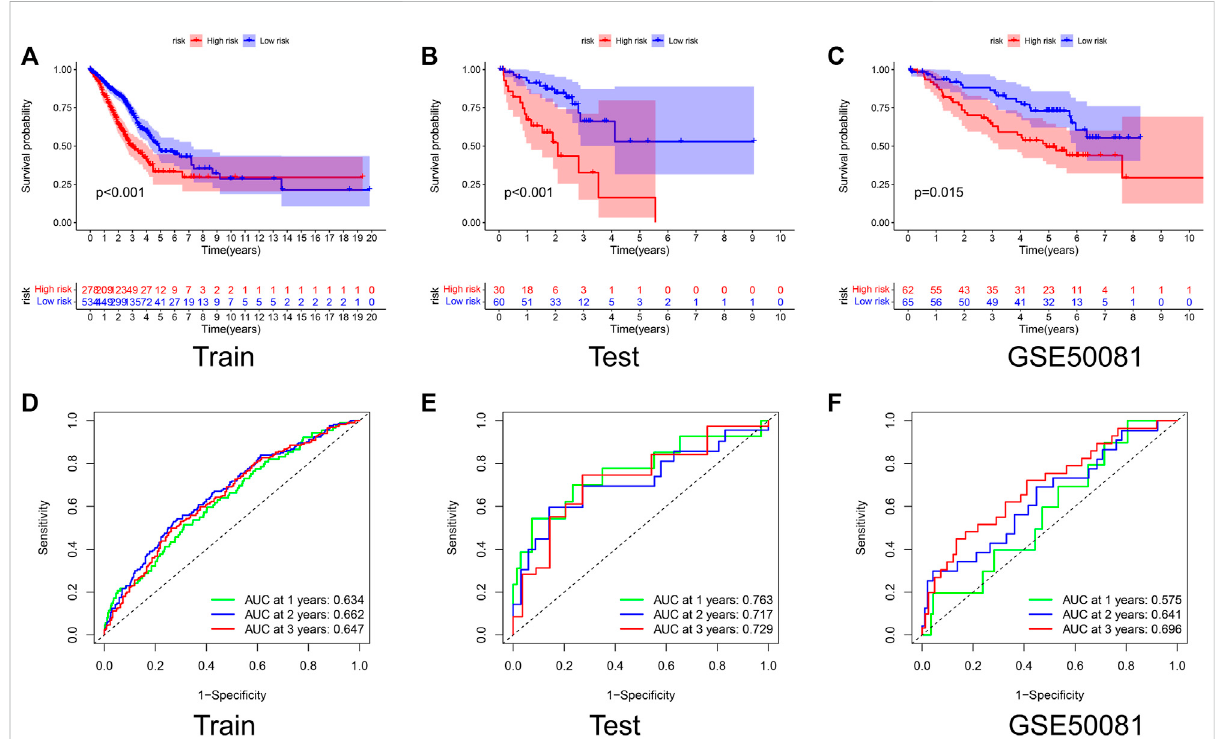
FIGURE 3 Validation oftheprognostic signature. Kaplan – Meiercurvepresentsdifferencesinoverallsurvival between thehigh-risk andlow-risk groups in theTrainset (A) ,Testset (B) ,andGSE50081 (C) .ROCcurvesoftheNRGsignatureforpredictingthe1/2/3-yearsurvivalintheTrainset (D) ,Testset (E) , and GSE50081 (F) . All results were statistically signi fi cant, demonstrating the good performance of the signature in assessing